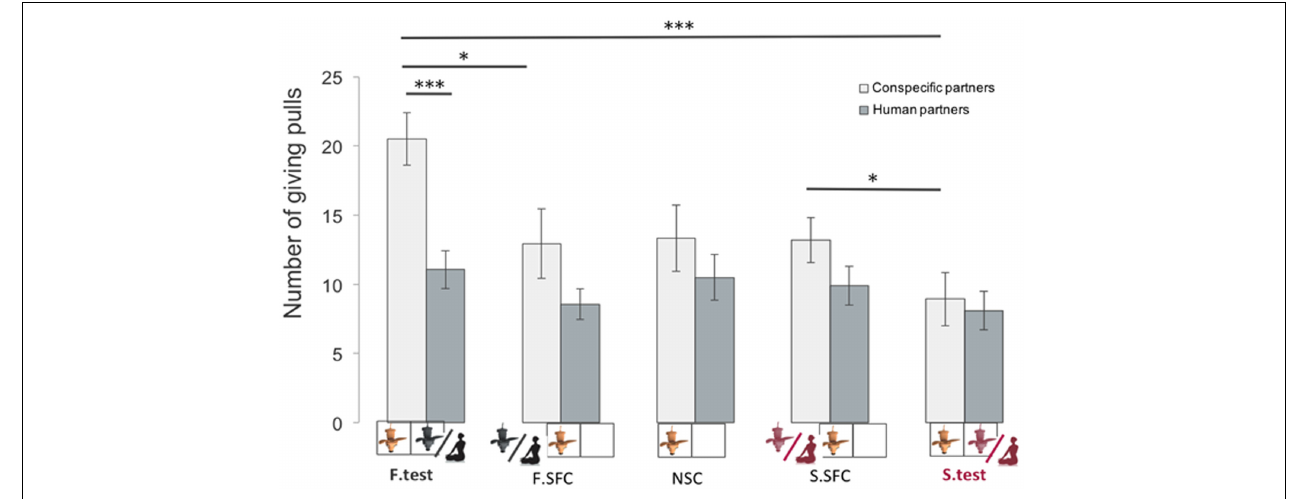
FIGURE 4 | Mean number of giving-pulls (mean ± SEM, n = 16 individuals for the experiment 1 and n = 18 for the second experiment) in which donors pulled the giving (0/1) tray across sessions ( ∗ p < 0.05, ∗∗ p < 0.01, ∗∗∗ p < 0.001).